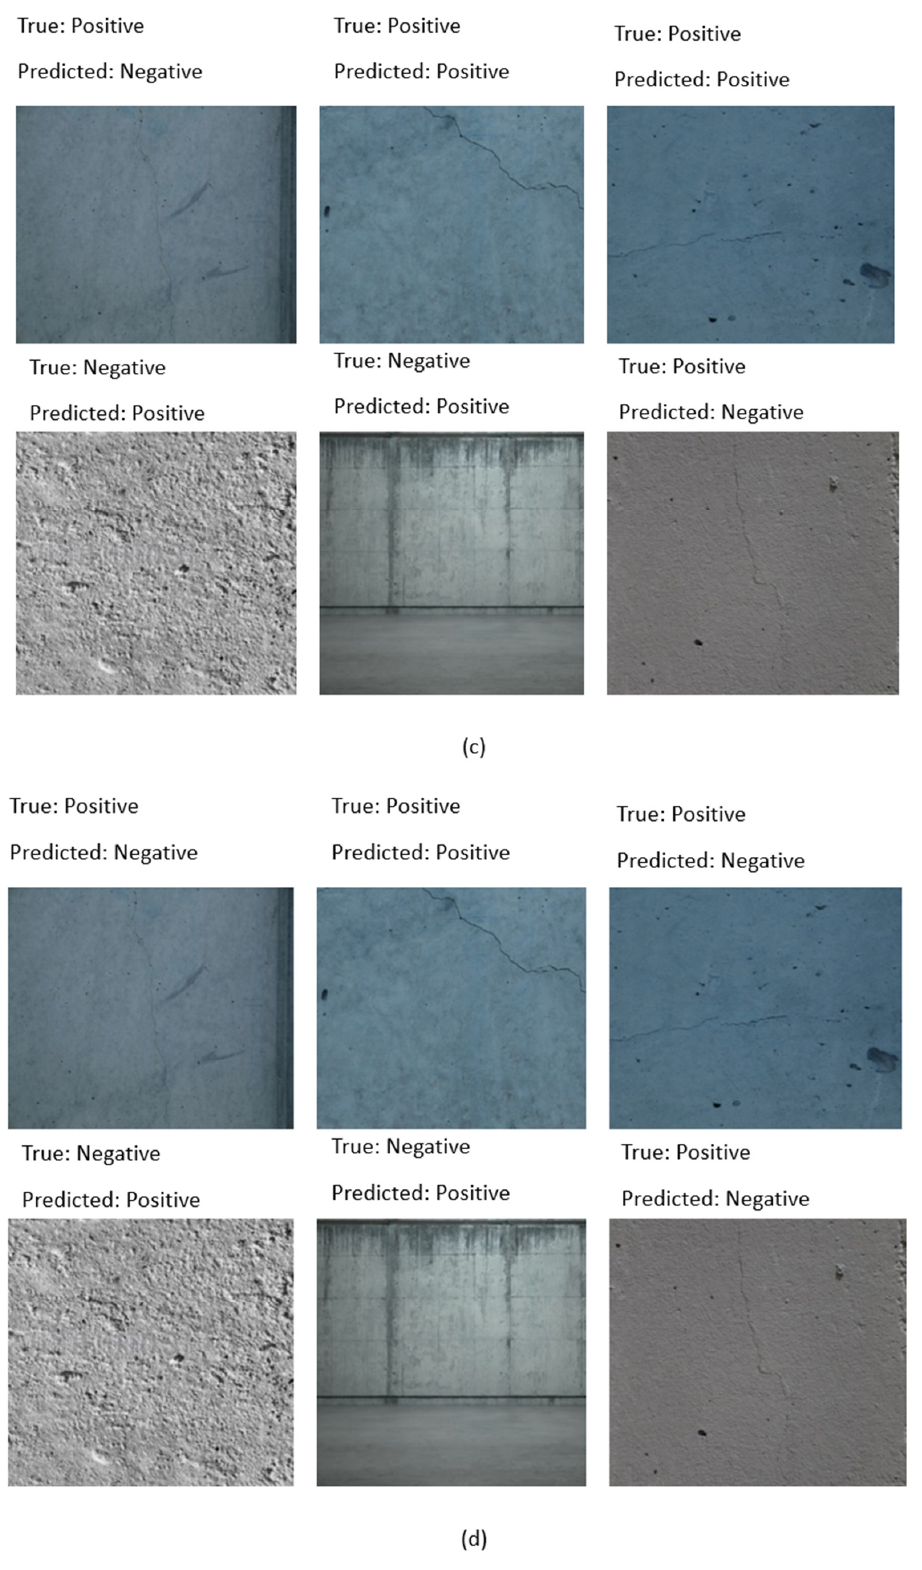
Figure 13. Classi fi cation result of test images ( a ) VGG16 ( b ) ResNet50 ( c ) MobileNet ( d ) Xception. Figure 13. Classification result of test images ( a ) VGG16 ( b ) ResNet50 ( c ) MobileNet ( d )